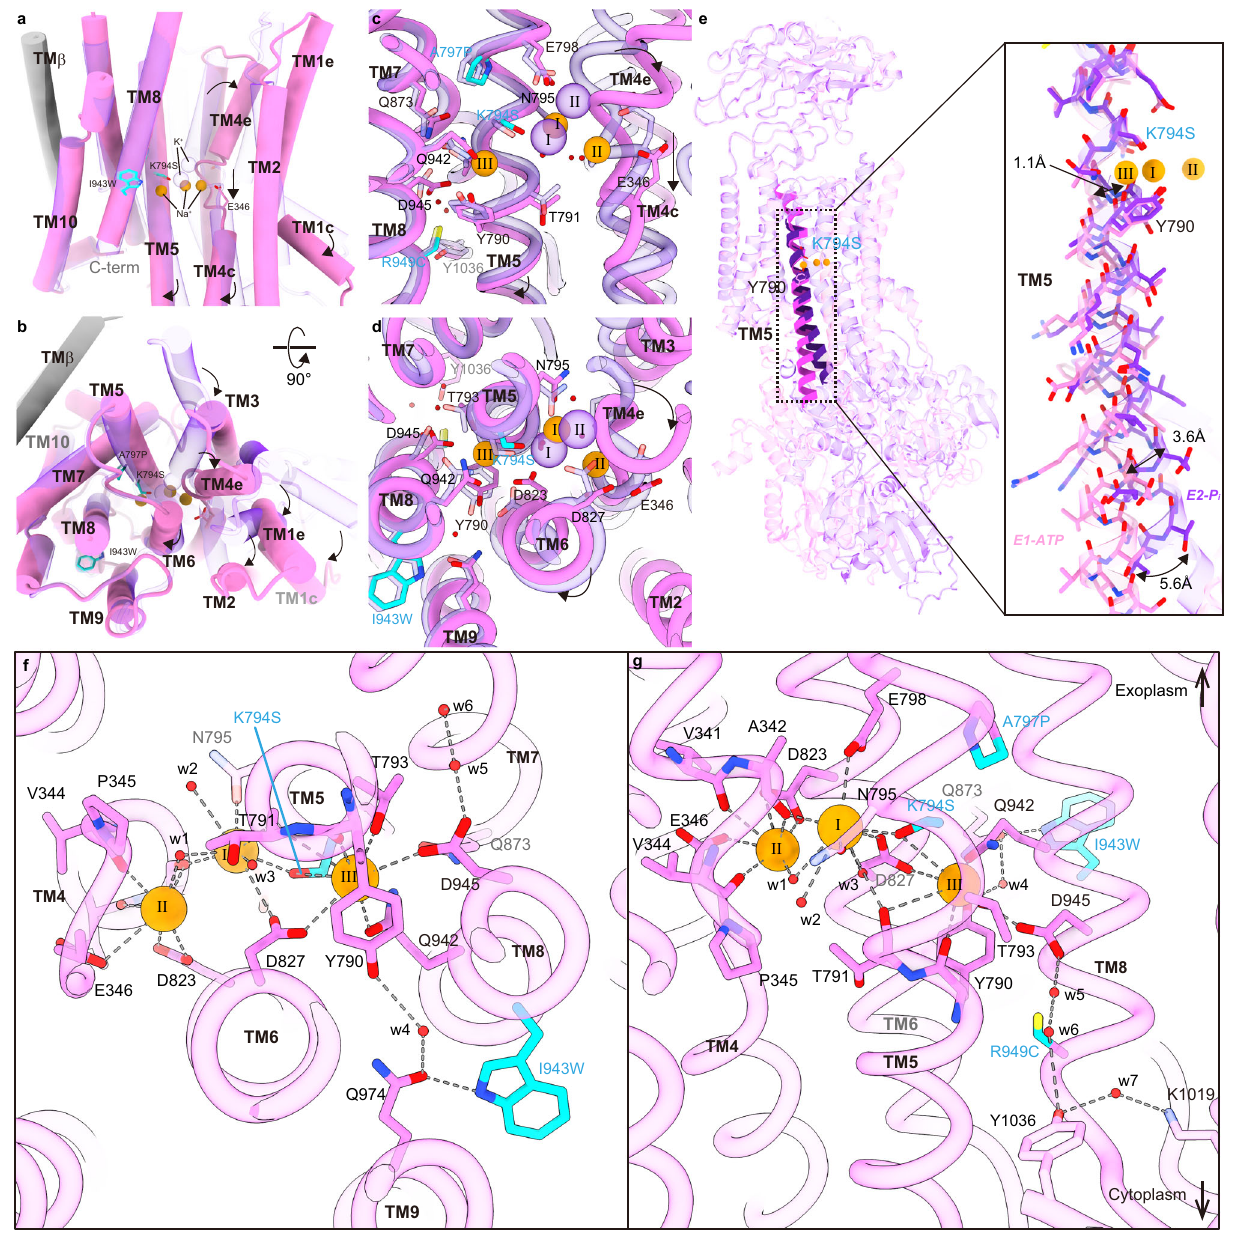
Fig. 8 | Na + -coordination and conformational changes of the SPWC-ngHKA mutant.a – d RearrangementofTMhelices( a , c :sideview, b , d :extracellularview) of the whole TM region ( a , b ) and around the cation-binding sites ( c , d ). Pink and transparent purple models represent 3Na + ·E1-ATP and (2K + )E2-P i state, respec- tively.ArrowsindicatethedisplacementofindicatedTMhelicesfrom(2K + )E2-P i to 3Na + ·E1-ATP state. e Bent (purple, (2K + )E2-P i ) and straightened (pink, 3Na + ·E1-ATP) TM5 helix. Overall view (left), and close-up view (right). Arrows indicate